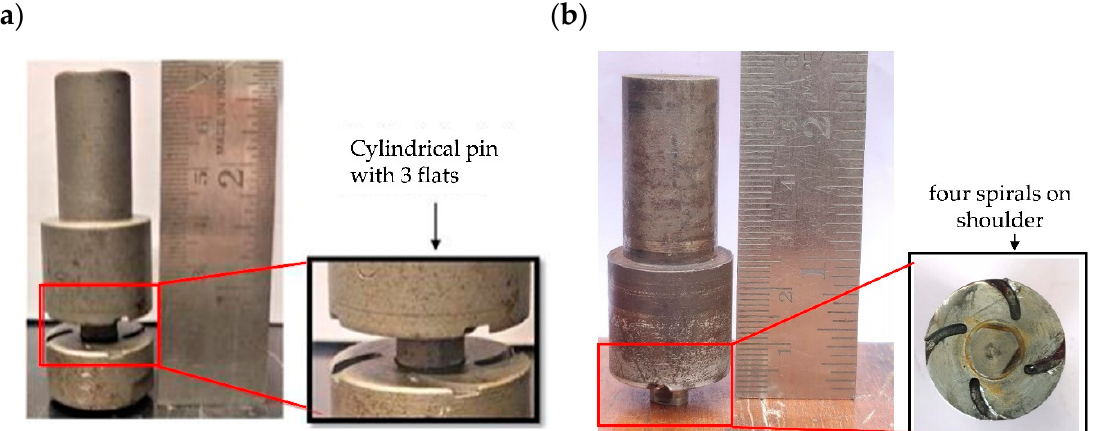
Figure 1. Stirring tool used for experiments ( a ) BTFSW tool ( b ) CFSW tool.